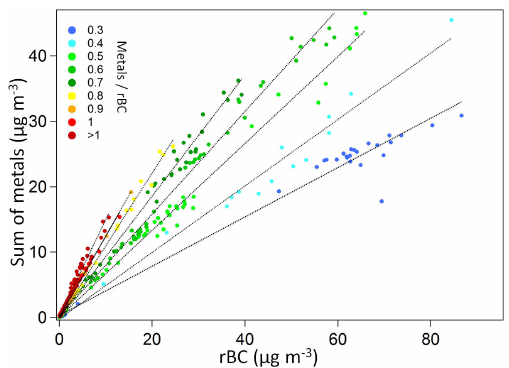
Figure 9. Mass concentration of the sum of all the metals measured at the heating station with the SP-AMS as a function of the rBC